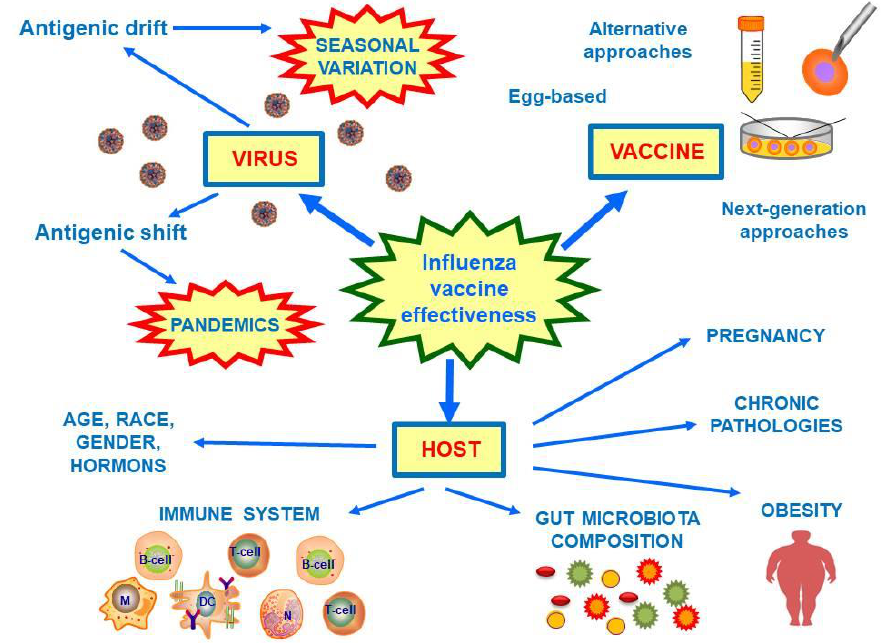
Figure 1. Factors involved in the influenza vaccine effectiveness. M, macrophage; DC, dendritic cell; N,